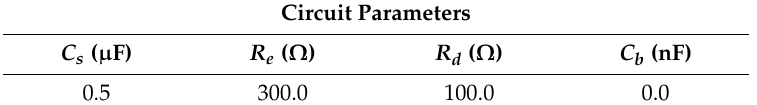
Figure 24. Comparison of the generated impulse voltage waveforms collected from the experiment and computed by the proposed method.